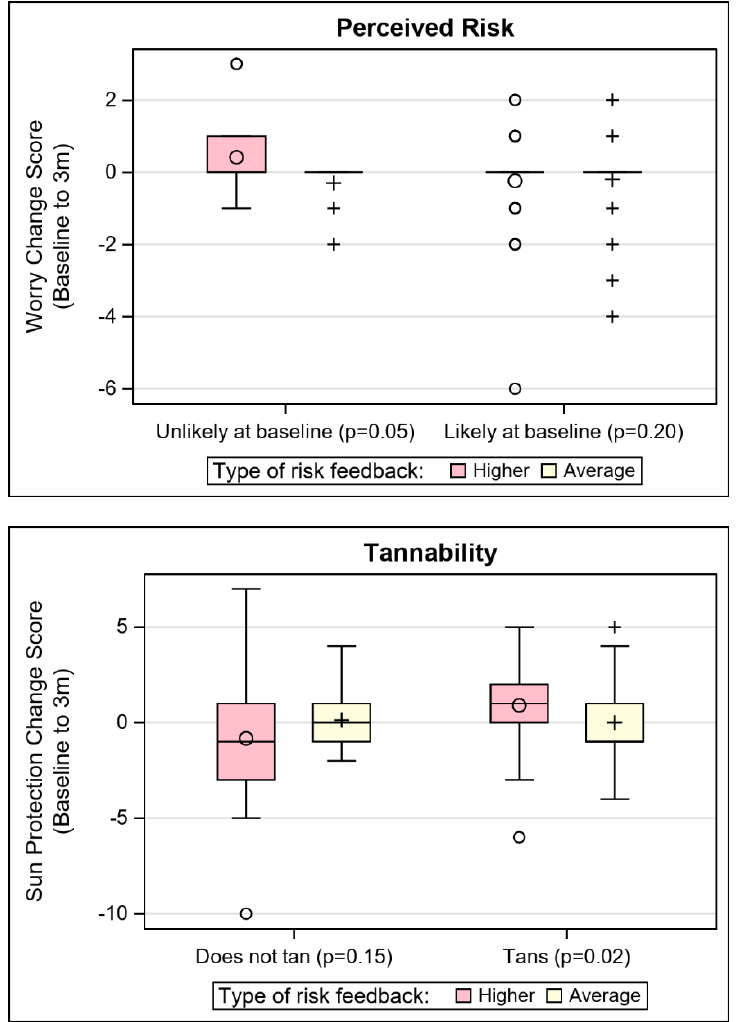
Figure 2. Depiction of notable sun protection and skin cancer worry moderator effects.